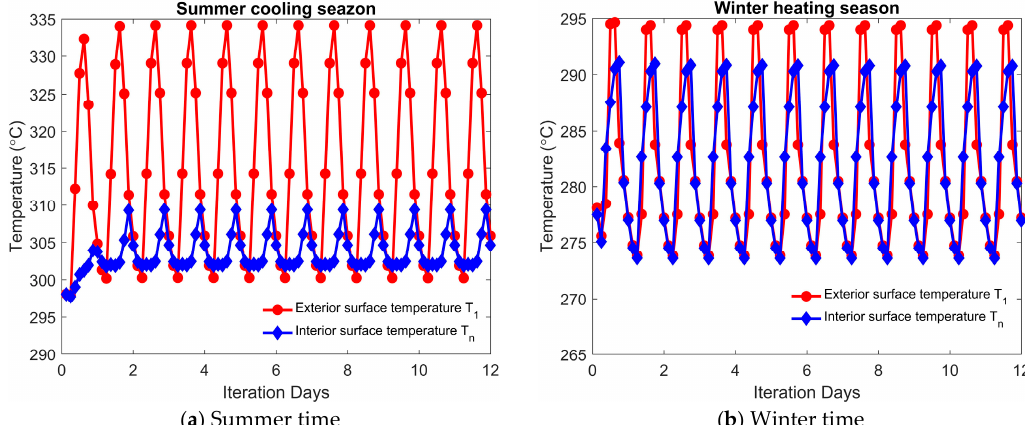
Figure 2. The temperature variation of Hanzhong city.